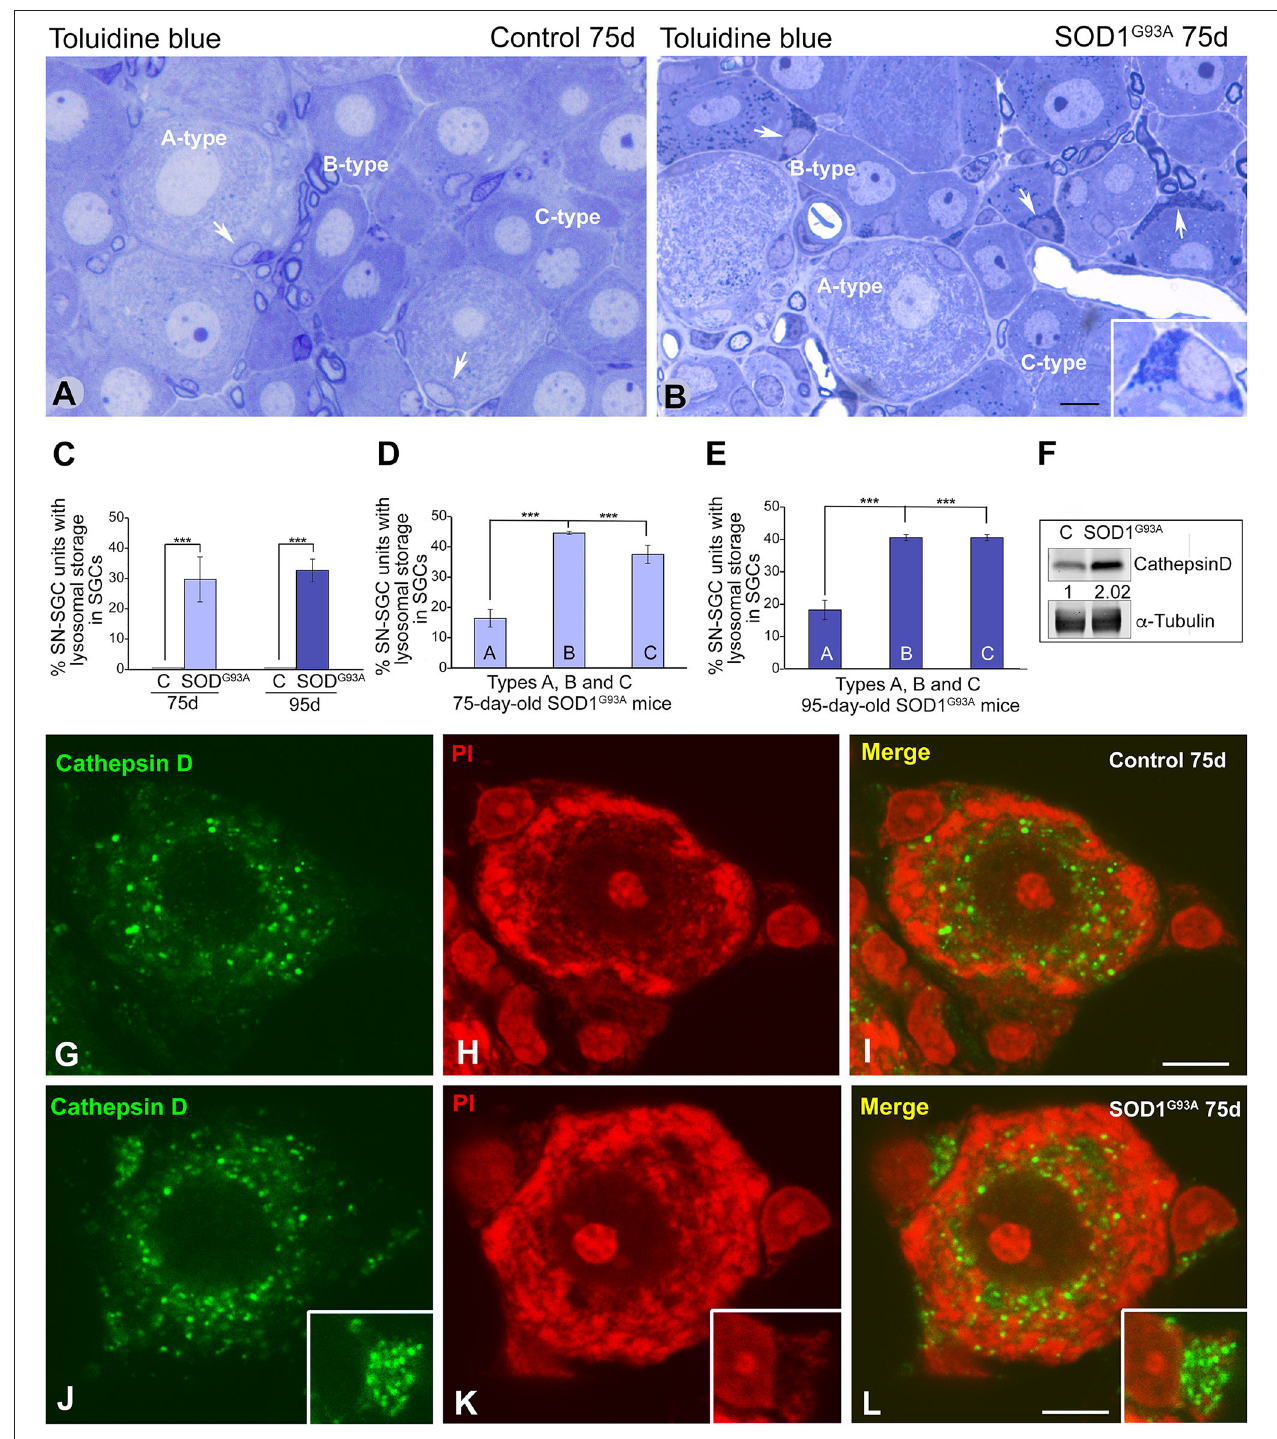
FIGURE 4 | SGCs from SOD1 G93 mice markedly increase the lysosomal compartment. (A,B) Semithin sections of DRG from control (A) and SOD1 G93 mice (B) stained with toluidine blue illustrating the organization of SN-SGC units. Note the accumulation of basophilic granules identified as lysosomes in some SGCs from SOD1 G93 mice (arrows and inset in B ). (C) Quantitative analysis of SN-SGC units from control and SOD1 G93 mice carrying basophilic granules in the SGC cytoplasm at 75 and 95 days of age. (D,E) Quantitative analysis of the proportion of types (A–C) SN-SGC units from SOD1 G93 mice carrying basophilic granules in the SGC cytoplasm at 75 (D) and 95 (E) days of age. (F) Representative example of a western blot of cathepsin D expression in DRG from SOD1 G93 and wild-type mice.